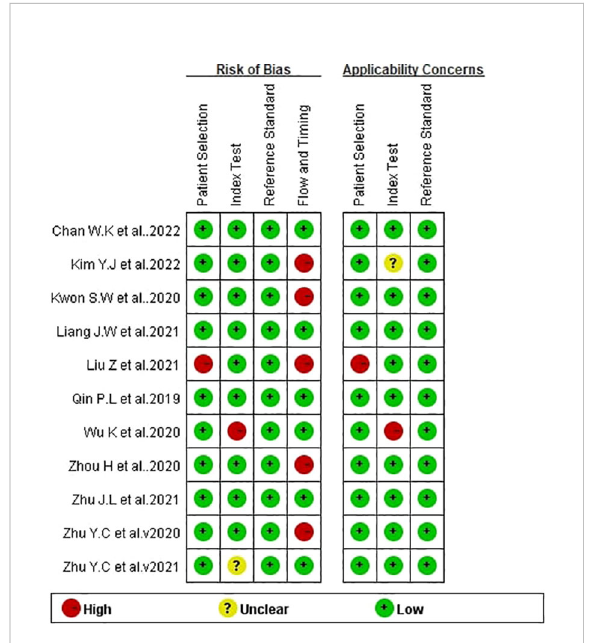
authors ’ assessment of each domain for each included